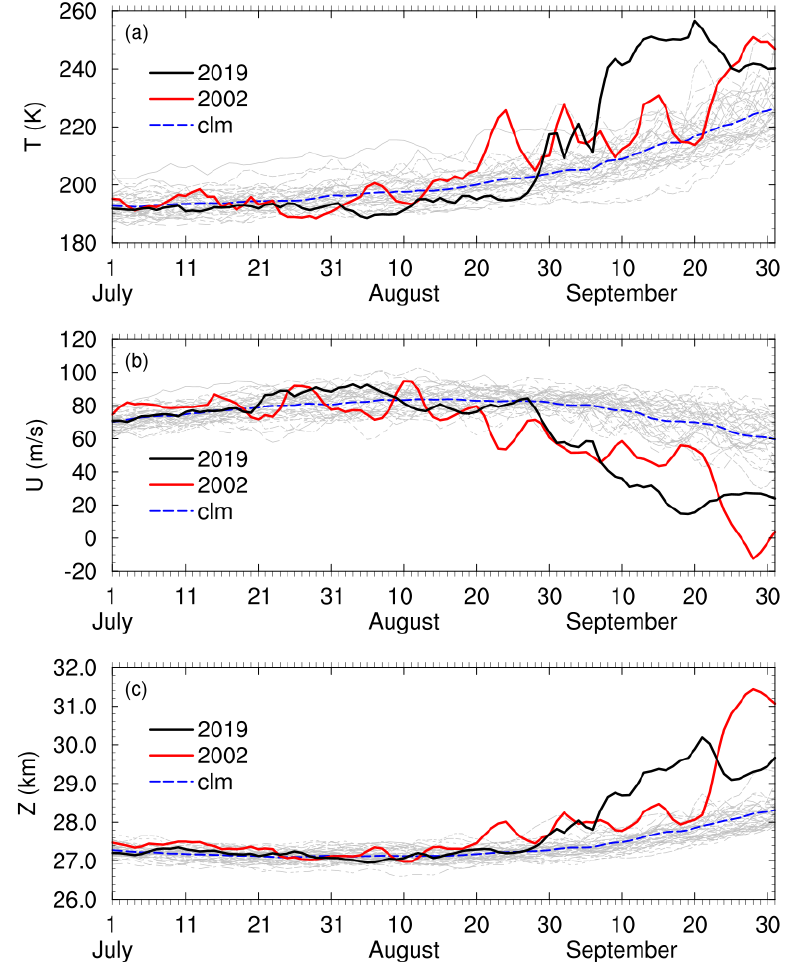
Figure 1. Time series of 10 hPa ( a ) Antarctic polar cap temperatures, ( b ) zonal-mean zonal wind at 60° S, and ( c ) Antarctic polar cap geopotential height averaged over 80° S–90° S from 1 July to 30 September in 2002 (red), 2019 (black), and other years (grey). Blue dashed lines represent the climatology.